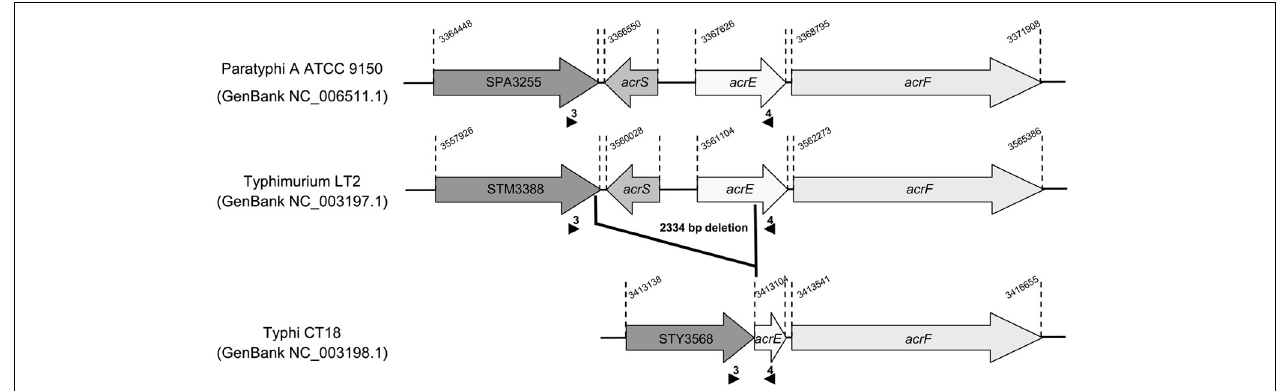
FIGURE 1 | Deletion identified in the acrSE region relative to the genome sequence of S . Typhi strain CT18 (GenBank NC_003198.1). The sequence of the acrSE region of S . Typhi strain CT18 is compared to those of S . Paratyphi A strain ATCC9150 (GenBank NC_006511.1) and